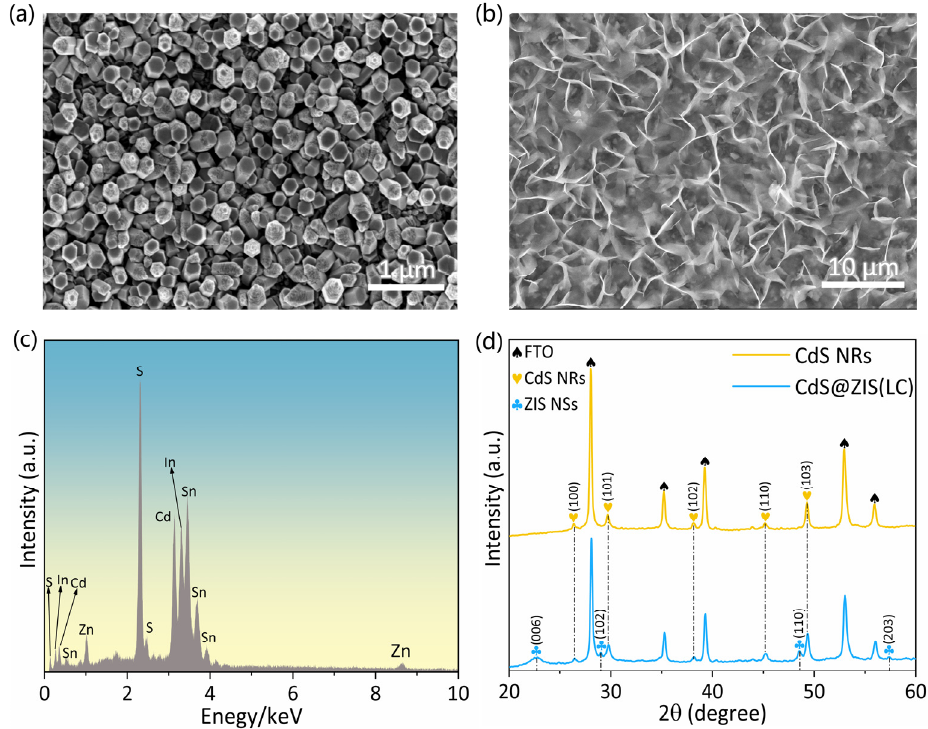
Figure 2. The FESEM images of ( a ) CdS NRs and ( b ) CdS@ZIS (LC); ( c ) EDS spectrum of CdS@ZIS; ( d ) XRD patterns of pristine CdS NRs and CdS@ZIS (LC).